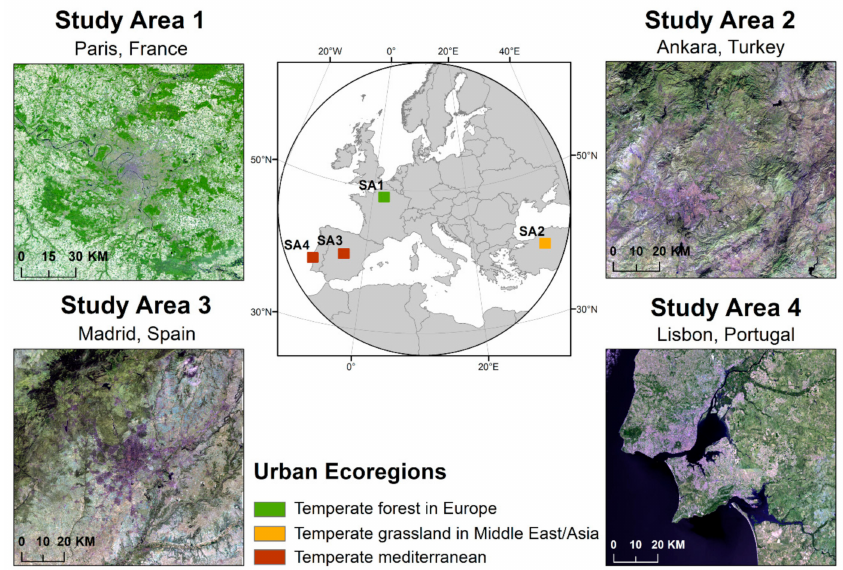
Figure 1. Location of the study areas. The Landsat-8 remotely-sensed images (in which Band 7 = Red, Band 6 = Green, and Band 4 = Blue (R7G6B4)) of the four study areas are shown.